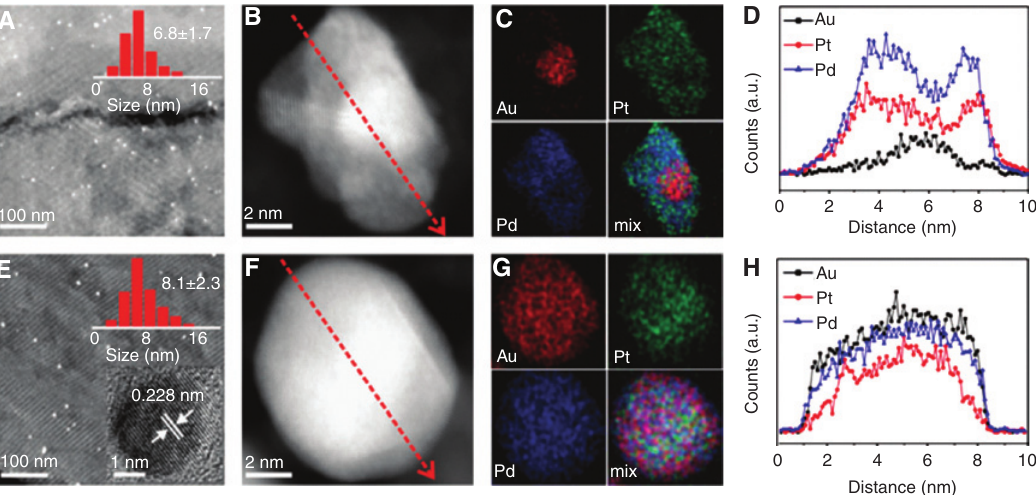
Figure 9: HAADF-STEM images and particle size distribution, typical HAADF-STEM images, corresponding EDS mappings and cross- sectional line-scanning profiles of Au (E) shows the typical HR-TEM image of Au Society of